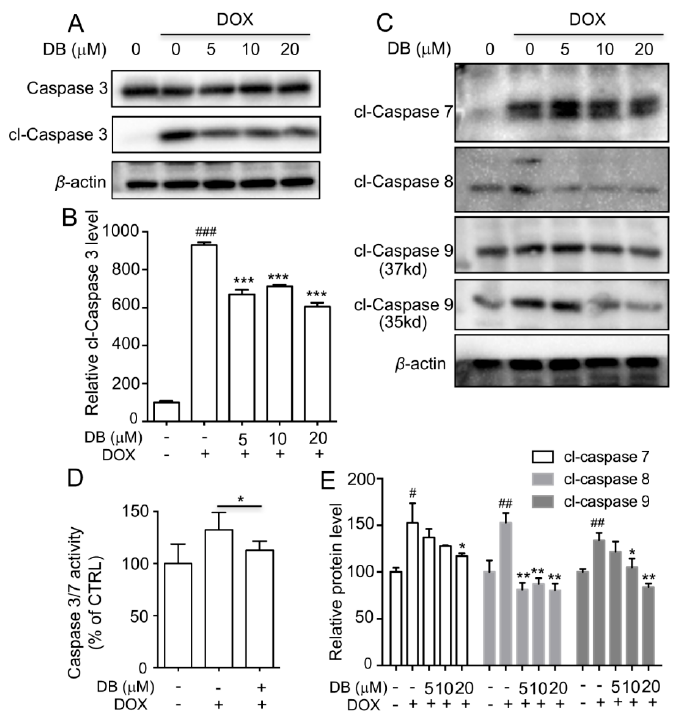
Figure 4. The inhibitory effect of DB on caspase activity induced by DOX. ( A ) DB regulated the expression of cleaved caspase (cl-caspase) 3 induced by DOX; ( C ) DB reversed the expression levels of cl-caspase 7, 8 and 9 induced by DOX. Cells were pre-treated with DB for 2 h and then co-treated with DOX for 24 h and the protein expression levels were followed assessed by Western blot analysis. β -actin served as the loading control; ( D ) DB decreased the caspase-3/7 activity induced by DOX. Cells were pre-treated with DB for 2 h and co-treated with DOX for 24 h followed by caspase 3/7 activity assay. * p < 0.05 versus DOX without DB; ( B , E ) Semi-quantitative analysis of Western blot analysis results. # p < 0.05, ## p < 0.01, ### p < 0.001 versus control and * p < 0.05, ** p < 0.01, *** p < 0.001 versus DOX. cl = cleaved.